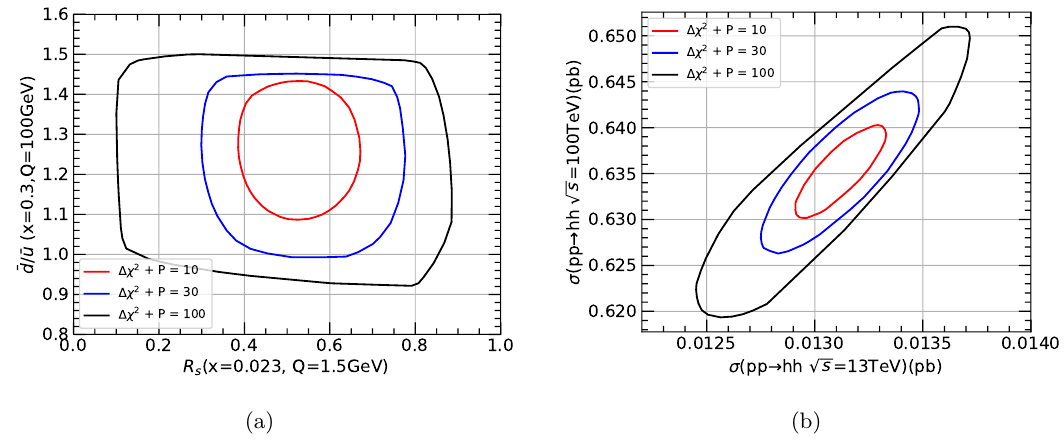
¯ d/ ¯ u ( x = 0 . 3 , Q = 100 GeV) √ s = 100